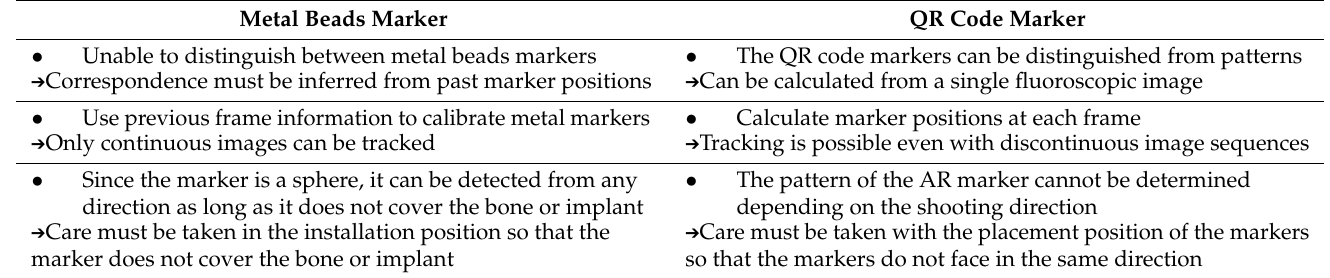
Figure 2. Algorithm of the QR code marker tracking. Table 1. Difference in the algorithm of the tracking for metal bead markers and QR code